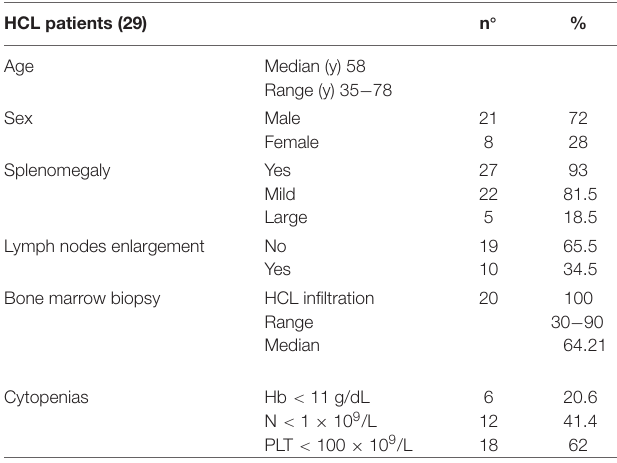
TABLE 1 | Clinical features of the enrolled HCL patients.